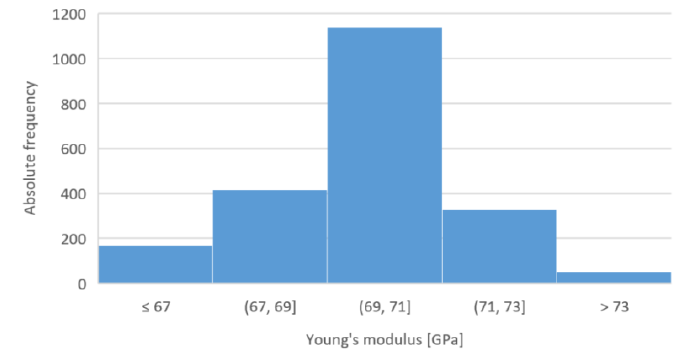
Figure 5. Young’s modulus histogram of the input